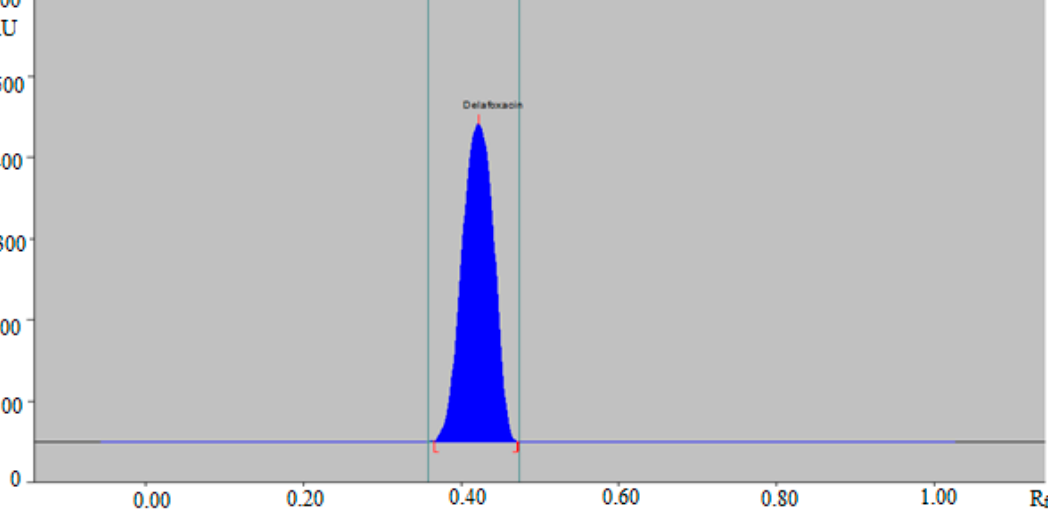
Table 2. Linear regression data for the calibration curve of DLFX for green RP ‐ HPTLC and NP ‐ HPTLC methods ( n = 6).